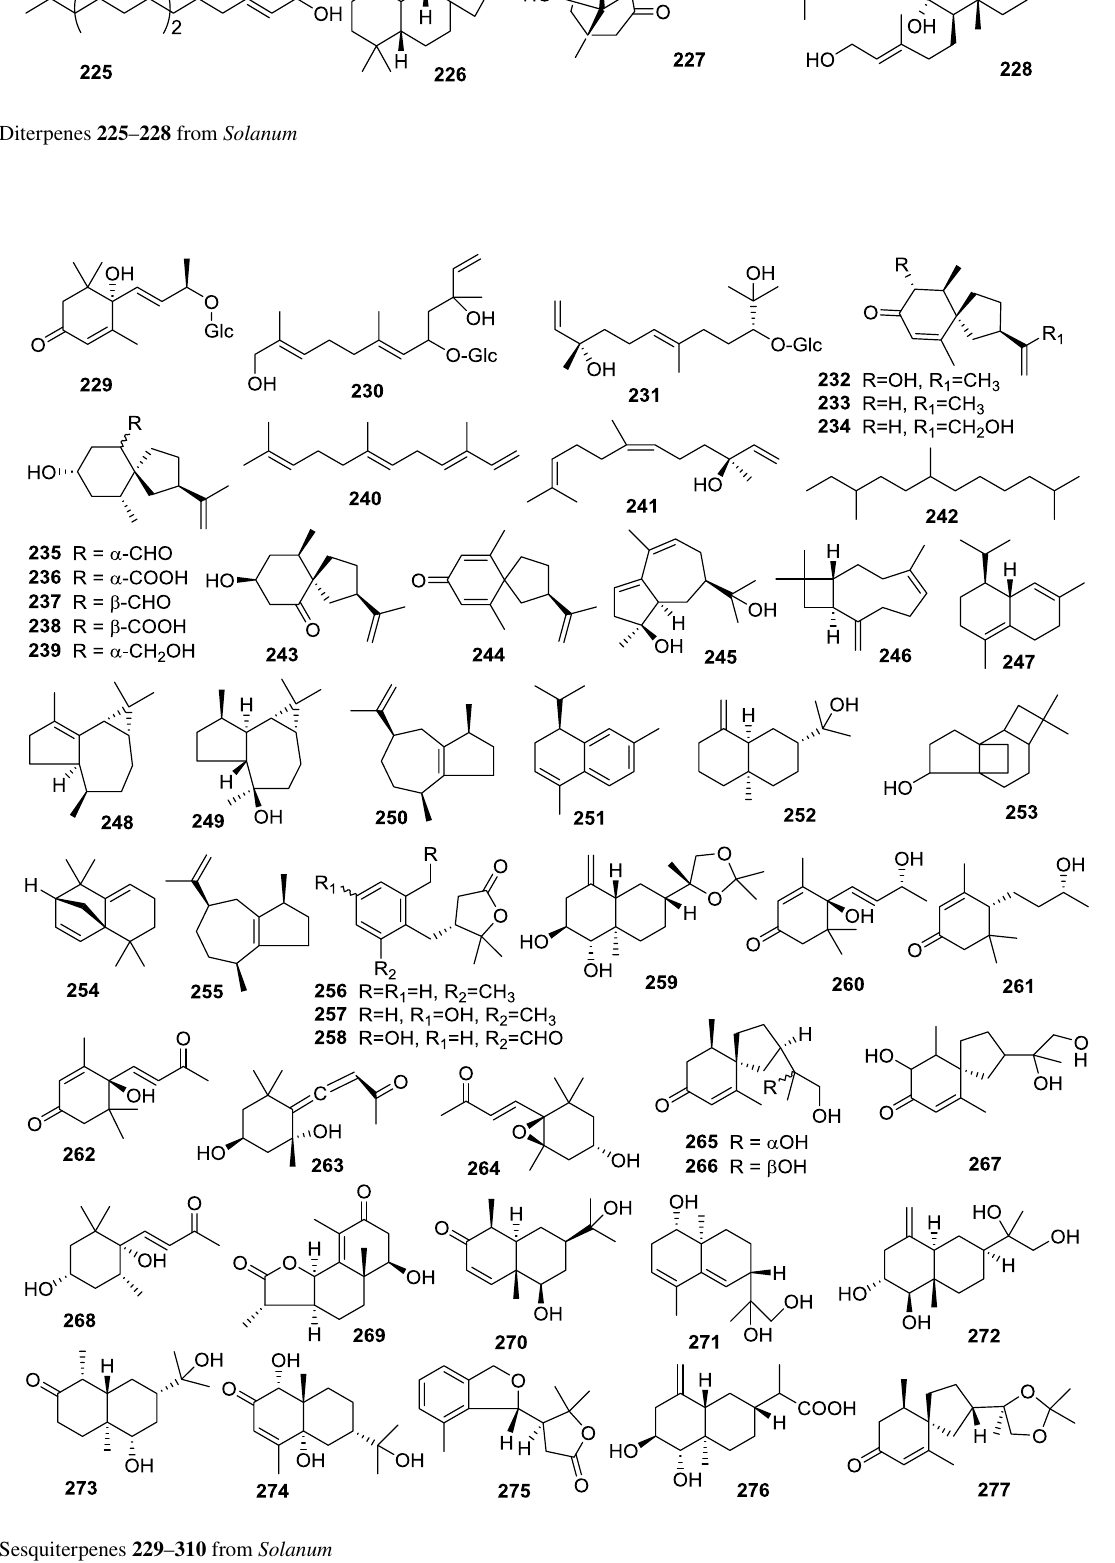
Fig. 6 Sesquiterpenes 229 – 310 from